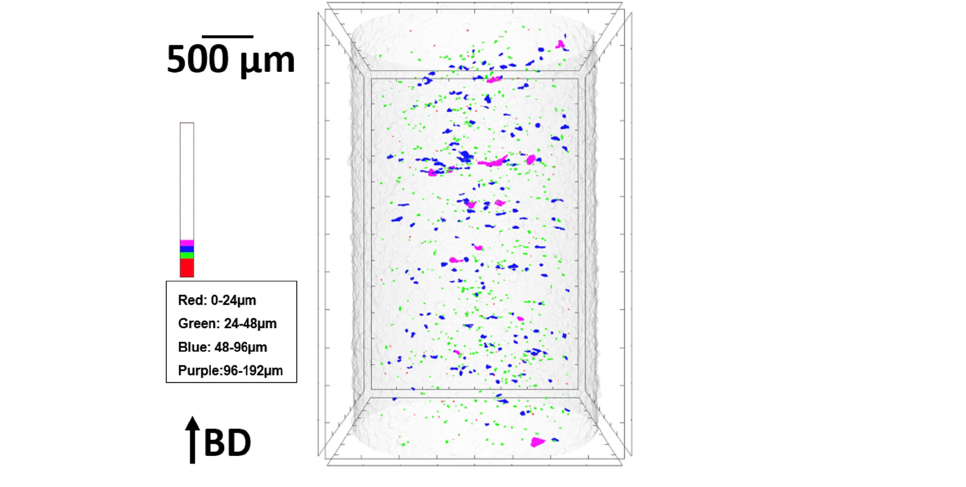
Table 5. Porosity and relative density of the as-built sample.